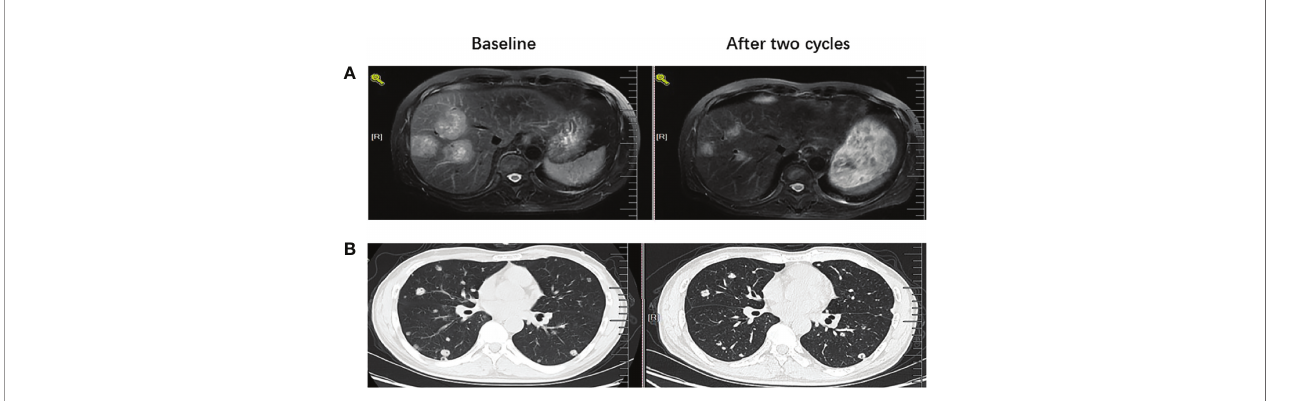
FIGURE 5 | MRI or CT images before and after treatment to show PR and SD results (A) left image showed baseline MRI images for one patient with liver metastases before the treatment with fruquintinib plus pd-1 inhibitor and right image showed the tumor reduction more than 50% after two cycles of treatment. (B) left image showed baseline CT images for one patient with lung metastases before the treatment with fruquintinib plus pd-1 inhibitor and right image showed the tumor remain stable after two cycles of treatment.